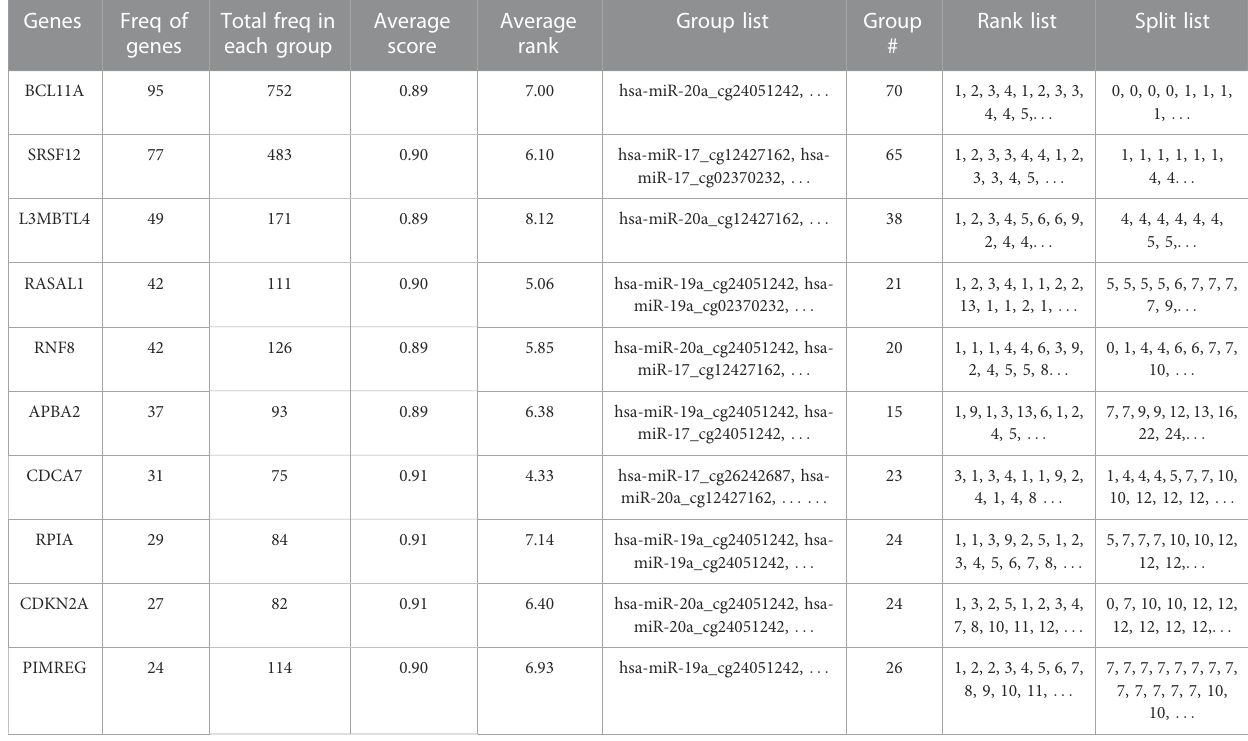
TABLE 2 Top ten most signi fi cant mRNAs/genes that are detected using 3Mint on BRCA molecular subtype dataset. Genes Freq of Total freq in genes each